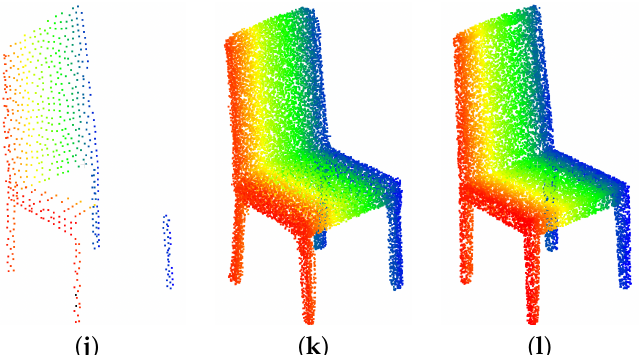
Figure 13. The above image shows examples of our method when applied to the PCN dataset. All point clouds are colored in the horizontal direction. Original occluded point clouds are on the left-hand side, the predicted clouds are in the center column, and the ground-truth point clouds are in the right-hand column.